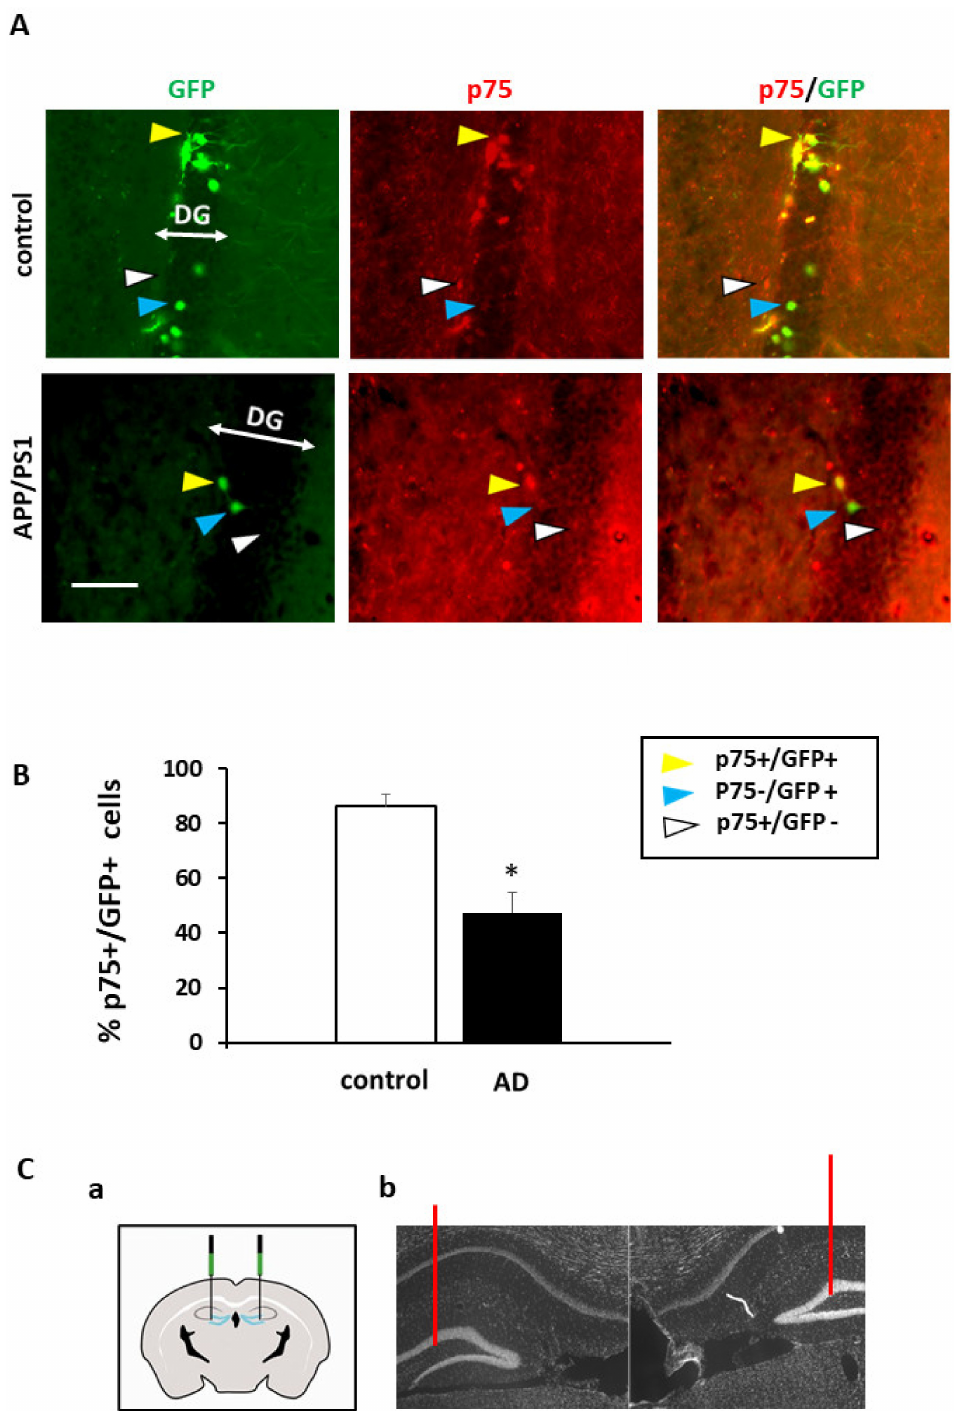
Figure 2. p75NTR expression in the DG of GFP retroviral injected mice. ( A ) Confocal images of the neurogenic cells transduced by GFP at 21 dpi, GFP+ cells (green) expressing p75NTR (red), p75NTR and GFP colocalization (merge). Example of colocalization of DCX and p75 compared to AD samples (yellow arrow), DCX+ and p75- cells (blue arrow) and DCX-and p75+ cells (white arrow). Scale bar = 10 µ m; ( B ) Bars show decreased co-localization of GFP and p75 in APP/PS1 model as compared to control. Bars are expressed as the mean of % of p75NTR+ on the DCX+ cells (p75/DCX) in the DG of APP/PS1 mice and controls. Positive cells are considered those with staining in the cell body. Enough pictures at 40 × were randomly selected to cover 300 DAPI positive neurons ( n = 5 mice per group); ( C ) Histological map of DG injection ( a ), DAPI staining of hippocampal region, showing injection sites in the DG (bars in red) ( b ). p ≤ 0.05 (*), p ≤